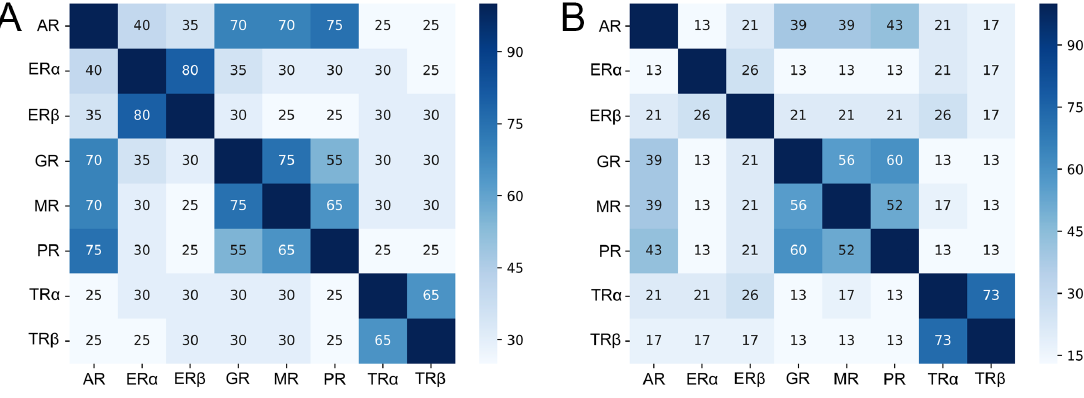
Figure 2. Sequence identity analysis of residues in ( A ) the AF-2 and ( B ) the BF-3 sites. The identity is given as a percentage of the maximally achievable score based on the considered